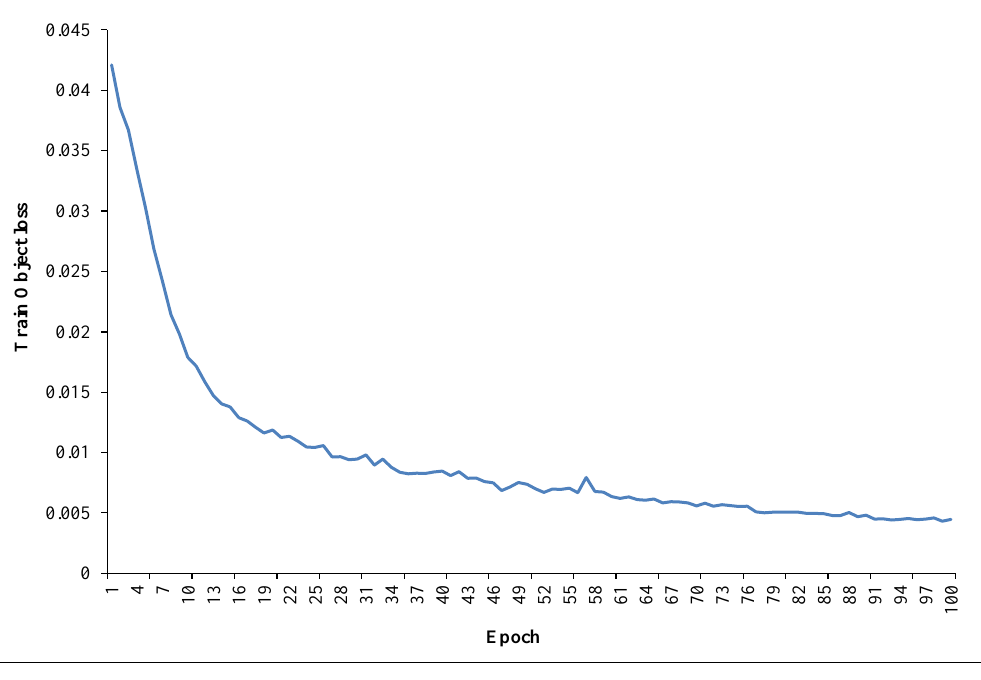
Figure 8. Yolov5s model training object loss vs